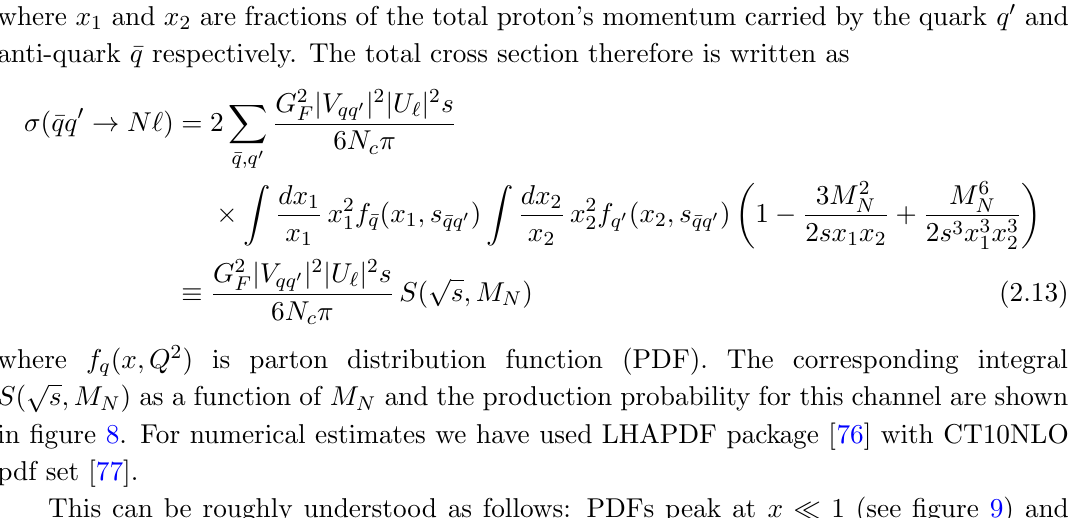
U ‘ = 1 (right panel) for p s = 100 GeV (blue j j 1 and condition (cid:24)